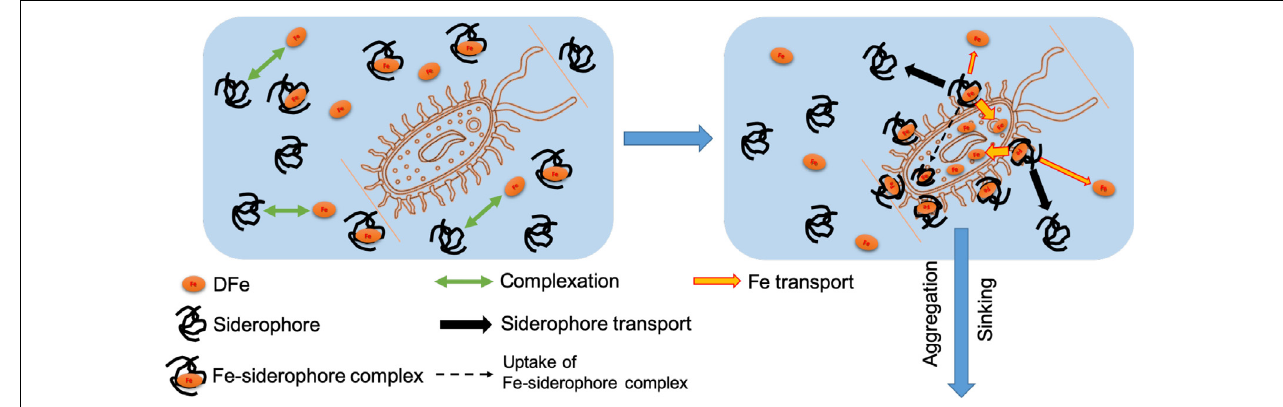
FIGURE 3 | Conceptual figure showing the transport pathway for the siderophore to the marine biomass/particles in the